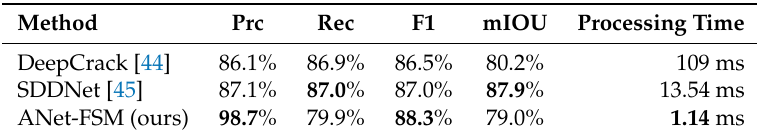
Table 8. Comparison of ANet-FSM architecture with crack detection architectures. The ANet-FSM architecture was trained and tested on the dataset prepared by DeepCrack